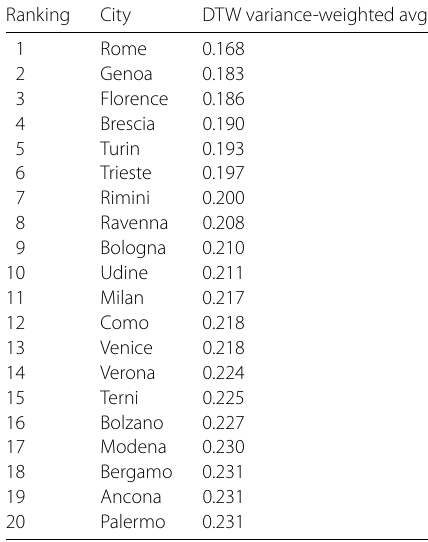
Table 4 The list of the 20 cities with the lowest variance-weighted average of the DTW distances. It is worth noting that cities with lower variance-weighted average DTW distances are the more synchronized ones Ranking City DTW variance-weighted avg. 1 Rome 0.168 2 Genoa 0.183 3 0.186